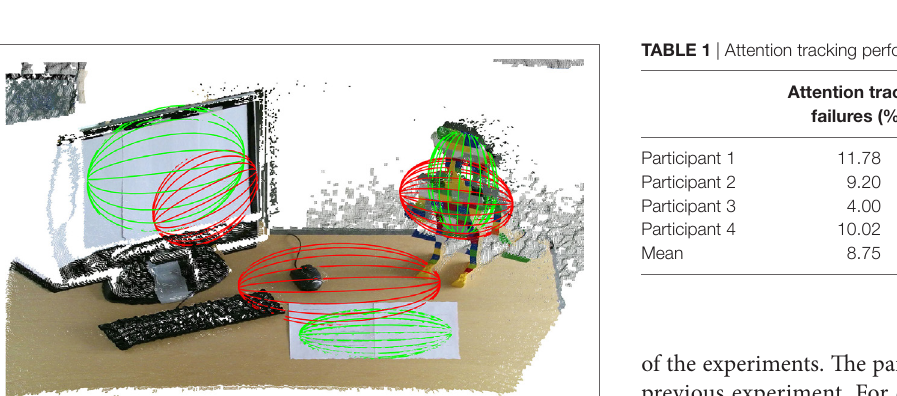
FigUre 5 | Displacement between the estimated targets of attention and the ground truth normal distributions N i,truth